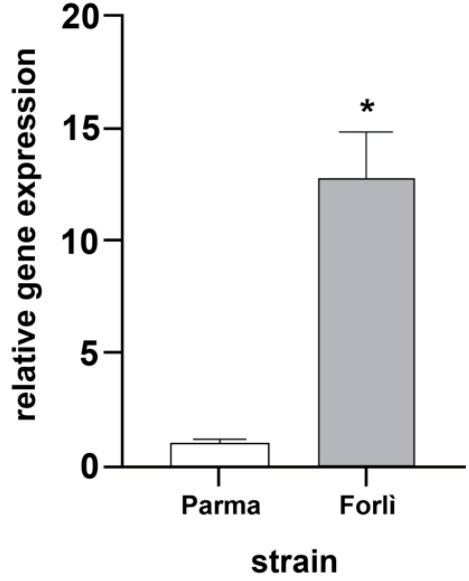
Figure 1. Analysis of chs 1 relative expression in Cx. pipiens . Relative expression of the chs 1 gene in the Parma (susceptible) and Forl ì (resistant) strains. Susceptible individuals were used as basal level (equal to 1). The values reported are the mean ± standard errors (* p < 0.001, Student’s t